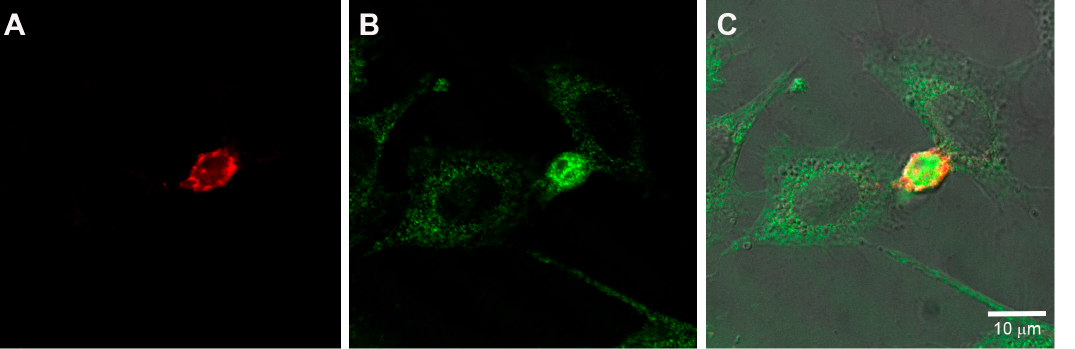
Figure 5. Connexin 43 is expressed in P815 mast cells and endothelial cells. ( A ) P815 mast cells were labeled with CellTracker™ Red CMTPX; ( B ) After 5 h of co-culture with SVEC4-10 cells, the cultures were immunostained with antibody against connexin 43 (green); ( C ) Merge of A and B. Images are representative of three independent experiments.